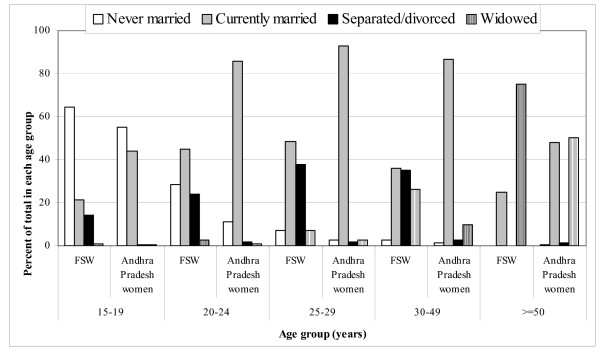
Distribution of marital status of female sex workers (FSWs) and of women in the state of Andhra Pradesh, India [13]. The age category of 15–19 years denotes 16–19 years for FSWs.